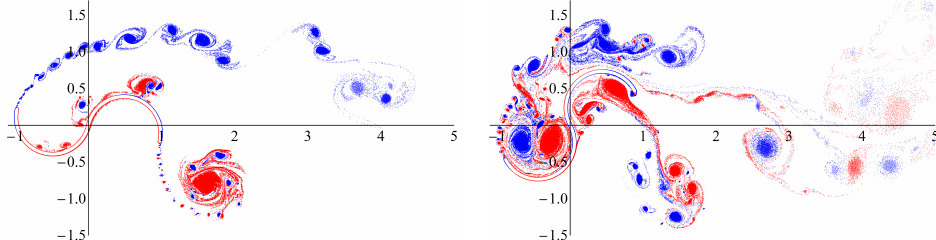
Figure 19. Vortex wake at the beginning of simulation (left figure, ¯ t = 6) and developed vortex wake (right figure, ¯ t = 32) around the rotating Savonius rotor (Re = 10 5 ). Comparison with OpenFOAM has been performed for a similar problem of rotor autorotation simulation; unsteady lift and drag forces are shown in Figure 20; at t = 0, the rotor had zero angular velocity. It is seen that results are in acceptable agreement.